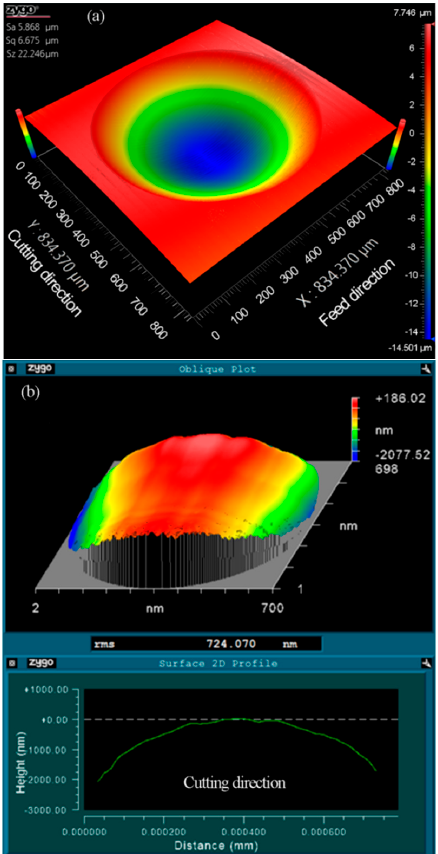
Figure 11. Zygo photographs of micro lens. ( a ) 3-D topography of machined micro lens; ( b ) The form error of machined micro lens surface from a designed sphere ( n = 400, t = 1 ms).